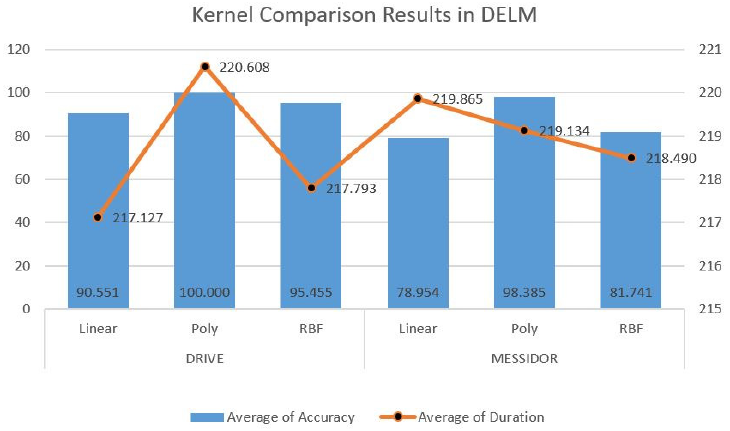
Figure 15. Kernel Comparison Results in DELM.